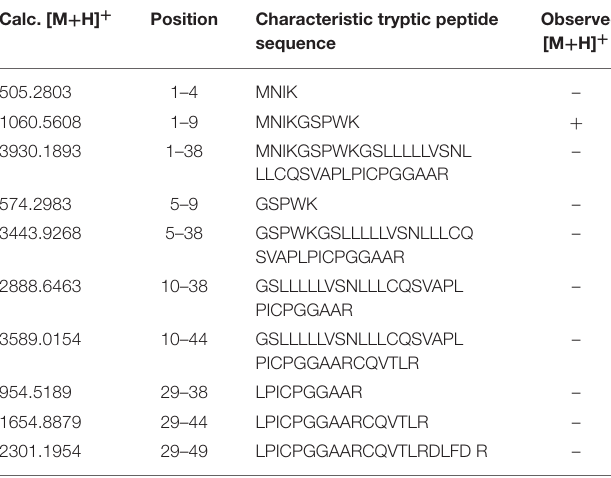
TABLE 5 | Characteristic tryptic peptides to determine signal peptide (position 1–28) within the identified hPRL variants. Calc. [M + H]